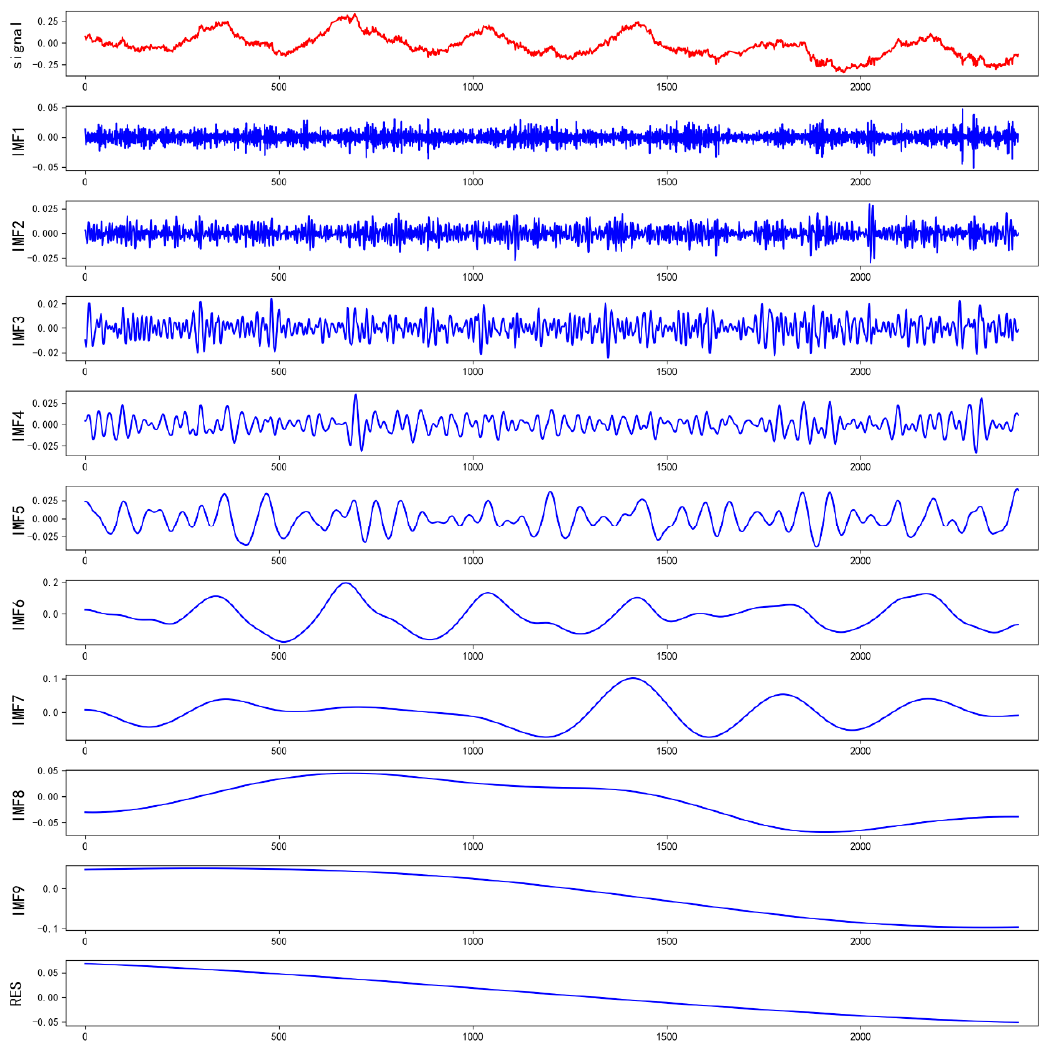
Figure 6. Diagram of dam deformation sequence decomposed by EEMD. Table 1. Evaluation results of IMF7 predictive